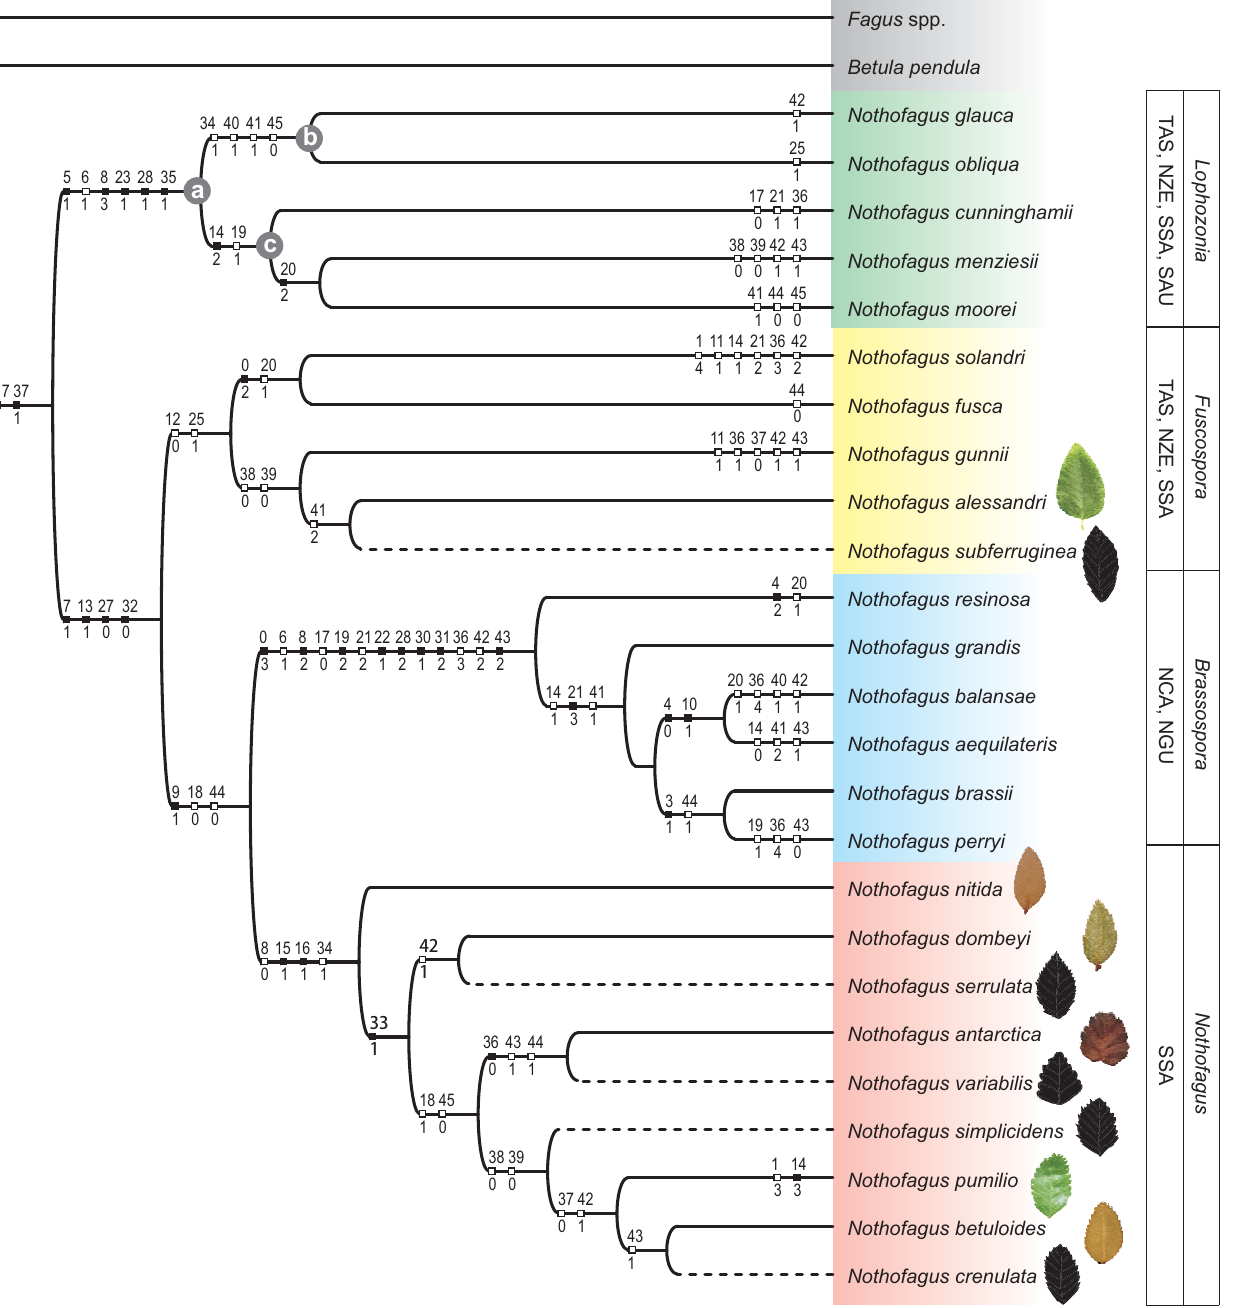
Fig. 1. Strict consensus tree from Implied Weight Analysis (IWA) (k = 8). Dashed cladogram branches indicate fossil taxa. Consistency Index (CI): 0.51; Retention Index (RI): 0.78. Shaded circles (a–c) indicate the three possible placements of the two taxa Nothofagus alpina and Nothofagus elongata before pruning as indicated by IterPCR. Green/brown and black leaves are representatives of living and fossil species, respectively. Abbreviations: NCA, New Caledonia; NGU, New Guinea; NZE, New Zealand; SAU, Southern Australia; SSA, Southern South America; TAS, issue is resolved in our new analysis where N. betuloides , N.